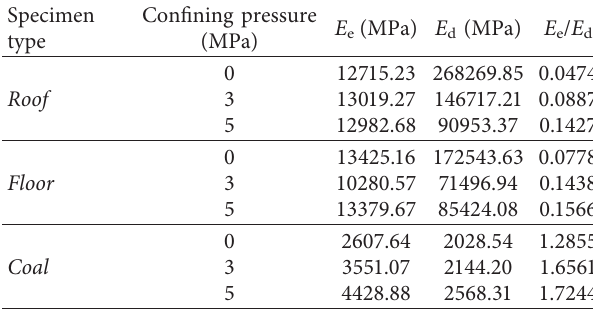
Table 1: Prepeak linear elastic modulus E descending modulus E d of the roof, the floor, and the coal spec- imens under different confining